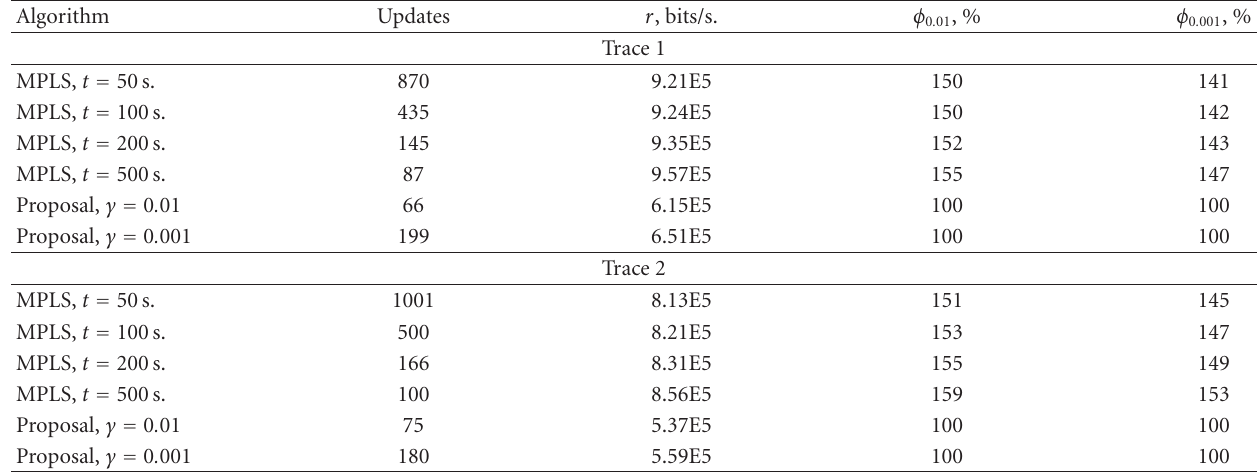
Table 2: Comparison with MPLS automatic bandwidth